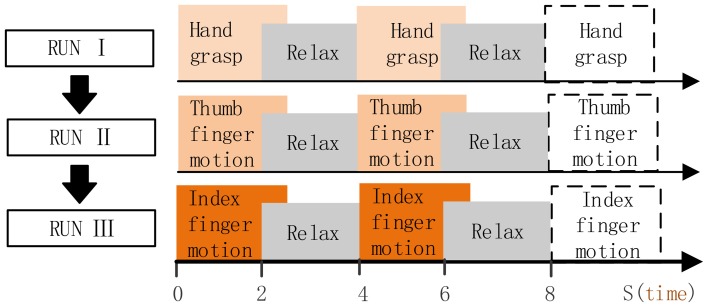
Full run experiment of subject P3, P4. RUN I, hand grasp; RUN II, thumb-finger motion; III, index-finger motion. Each run contained 20 trials, each trial lasts 4~6 s.